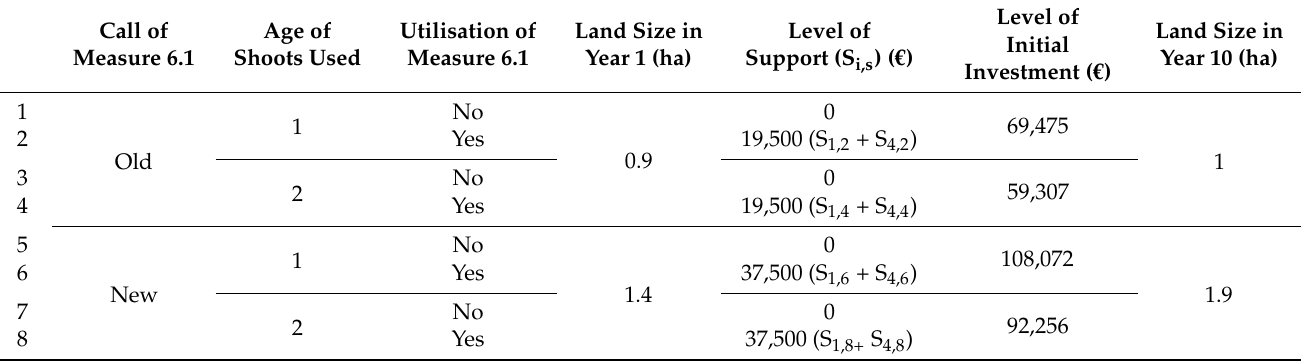
Table 2. Description of the scenarios examined in this